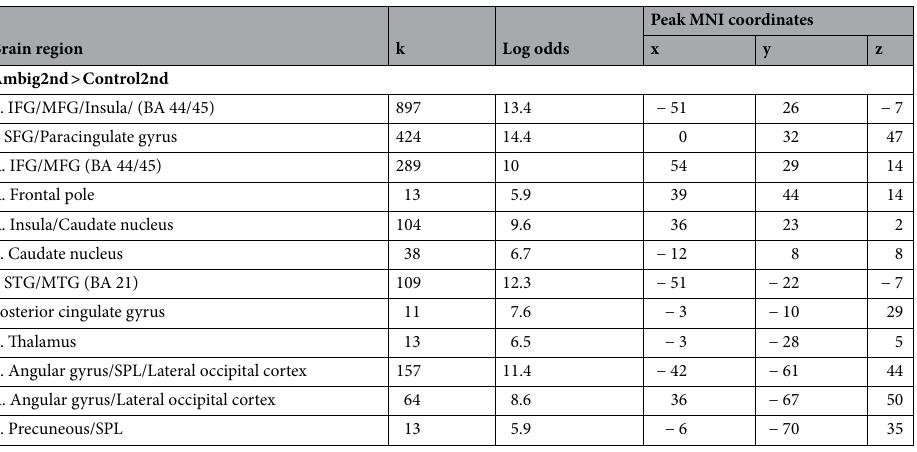
Table 2. Increases of the BOLD signal associated with proactive interference between the previously chosen solution inappropriate in the new context and the correct alternative solution for fragmented word pairs in the Ambig2nd condition. Denotations: L/R left/right hemisphere, k cluster size in voxels, BA Brodmann area, IFG inferior frontal gyrus, MFG middle frontal gyrus, STG superior temporal gyrus, MTG middle temporal gyrus, SPL superior parietal